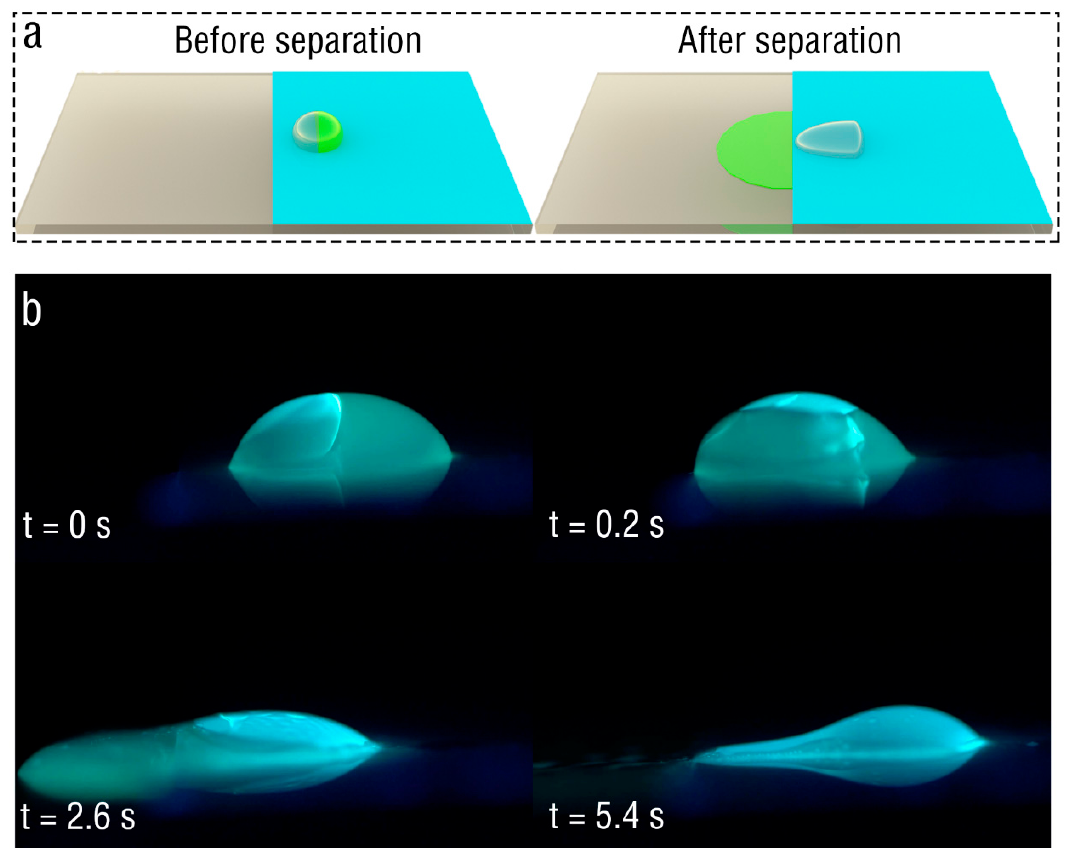
Figure 4. Separation of oil and water droplets. ( a ) Schematic diagram of the experimental case. ( b ) Image of separation process of the oil and water droplet under corona discharge.